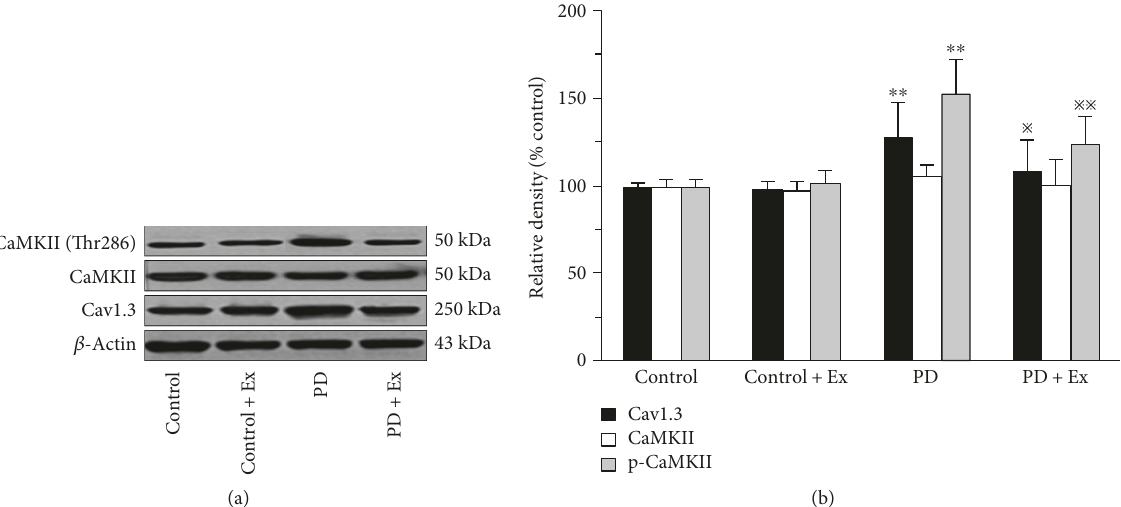
Figure 10: Protein expression of Cav1.3, CaMKII, and p-CaMKII in the rat ’ s striatum. Compared to the control groups, ∗∗ P < 0 01 . Compared to the PD groups, ※ P < 0 05 and ※※ P < 0 01 . Control: control group; Control +Ex: control plus exercise group; PD: Parkinson ’ s disease group; PD +Ex: Parkinson ’ s disease plus exercise